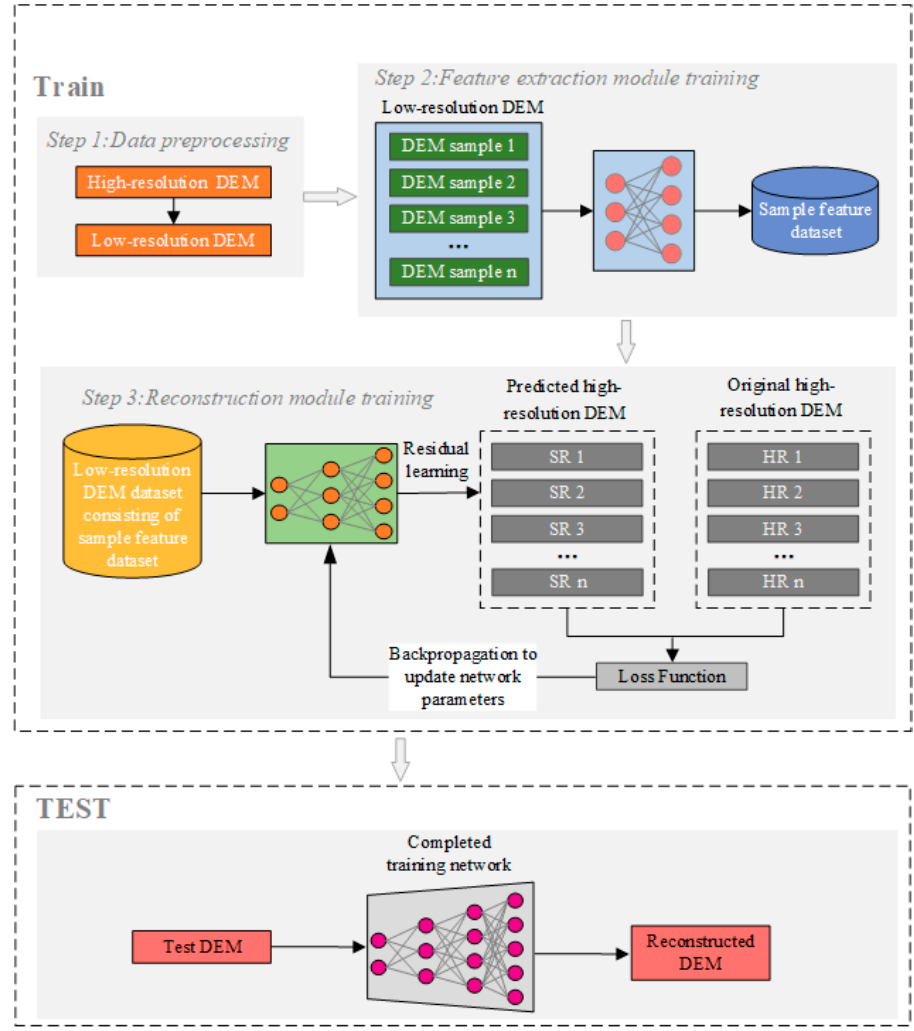
Figure 6. Network